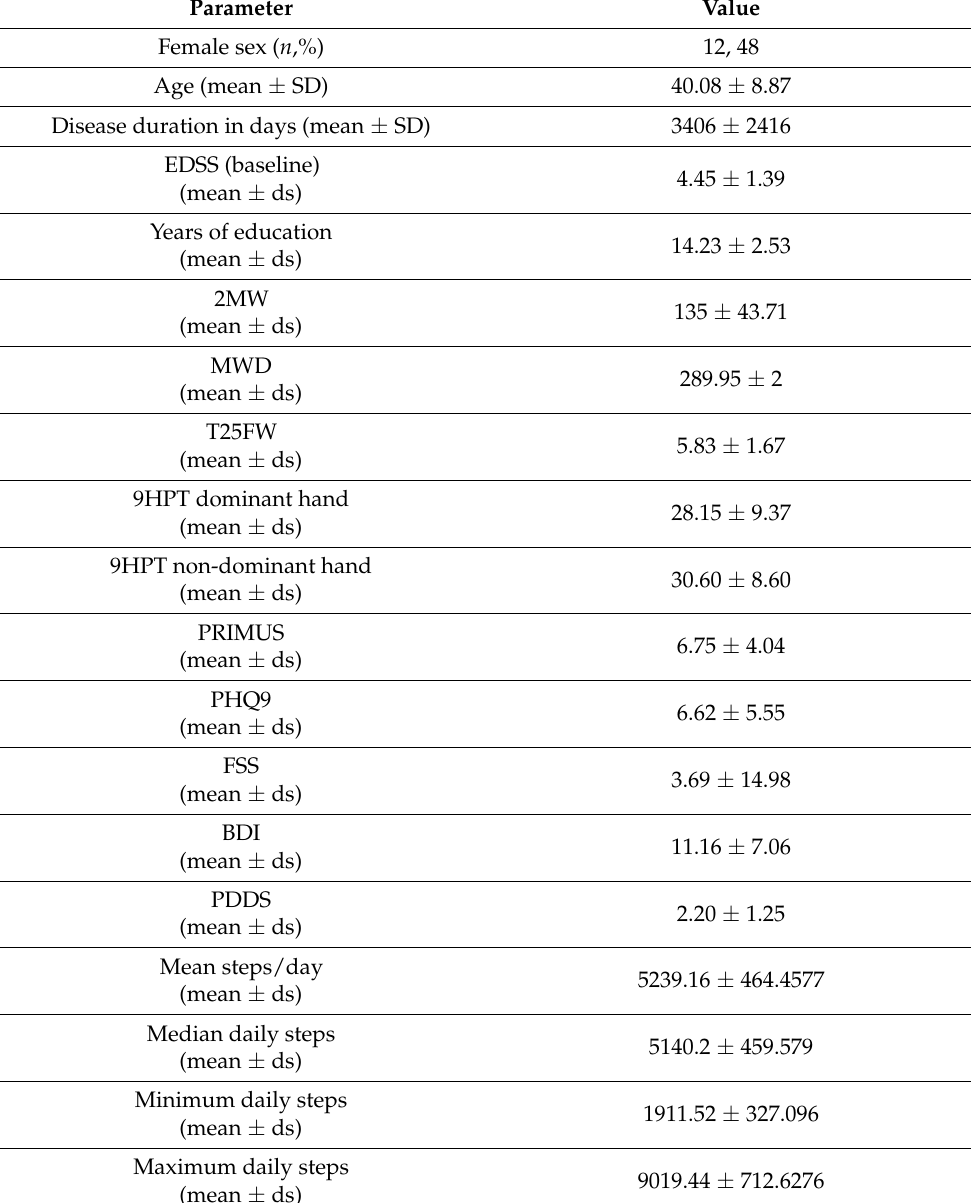
Table 1. Demographic and clinical characteristics of